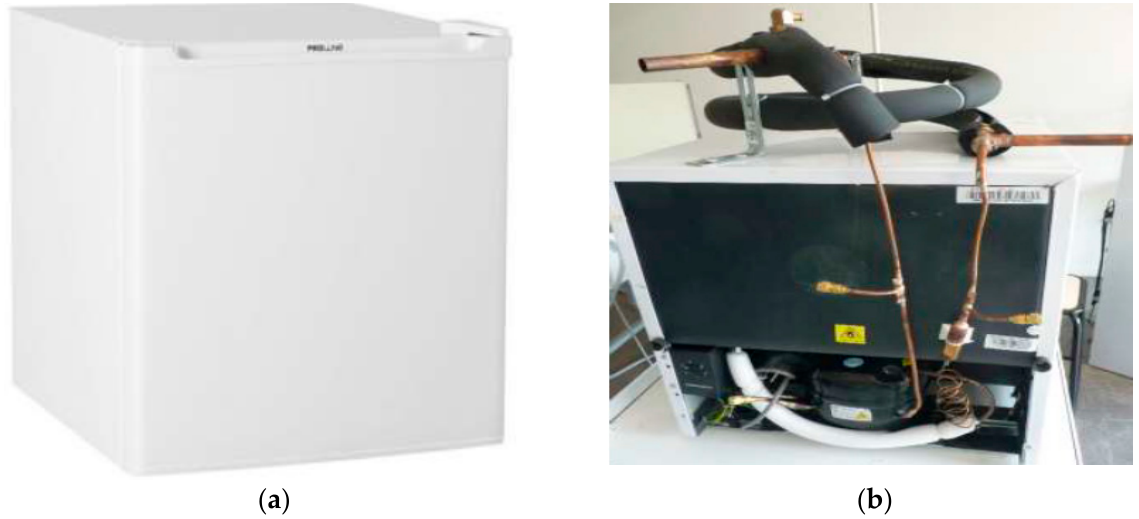
Figure 1. Heat pump for the simultaneous production of cold and heat ( a ) picture of the refrigerator and ( b ) photo of the refrigeration machine modified.